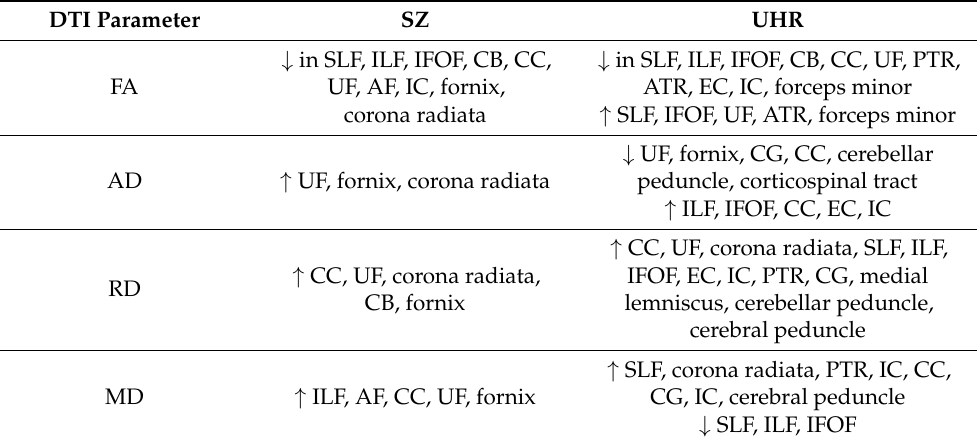
Table 2. Comparison of DTI indices between schizophrenia patients (SZ) and UHR individuals. DTI Parameter SZ UHR